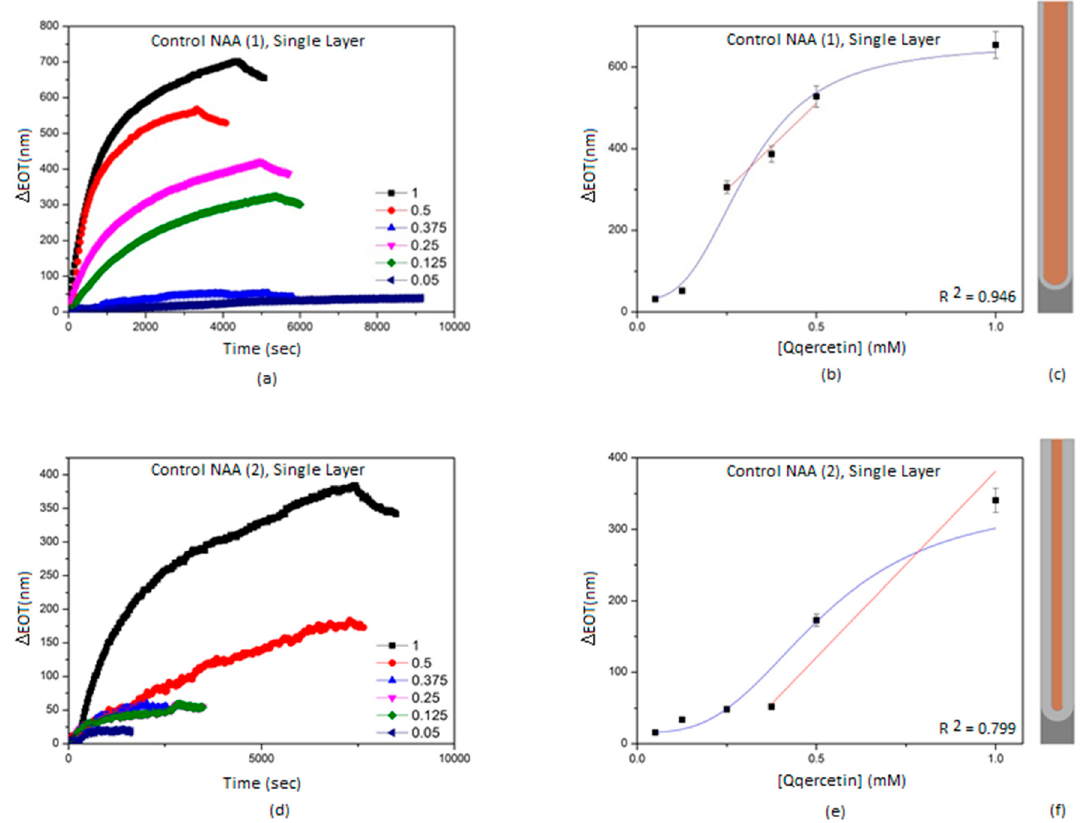
Figure 8. Time response curves showing effective optical thickness changes and fitting curves for control NAA (1) and NAA (1) sensing platforms measured by RIfS as a function of quercetin concentration (0.05, 0.125, 0.25, 0.375, 0.5, and 1 mM). ( a ) Δ EOT generated from single layer nanoporous structure of NAA (1) platform; ( b ) Sigmoid fit (blue) and the linear fit (red) for NAA (1) between Δ EOT and the different concentration of quercetin (0.05, 0.125, 0.25, 0.375, 0.5, and 1 mM) are presented; ( c ) Scheme of representative optical layer as a function of Δ EOT assessment; ( d ) Δ EOT generated from single layer nanoporous structure of NAA (2) platform; ( e ) Sigmoid fit (blue) and the linear fit (red) for NAA (2) between Δ EOT and the different concentration of quercetin (0.05, 0.125, 0.25, 0.375, 0.5, and 1 mM) are presented; ( f ) Scheme of representative optical layer as a function of Δ EOT assessment.